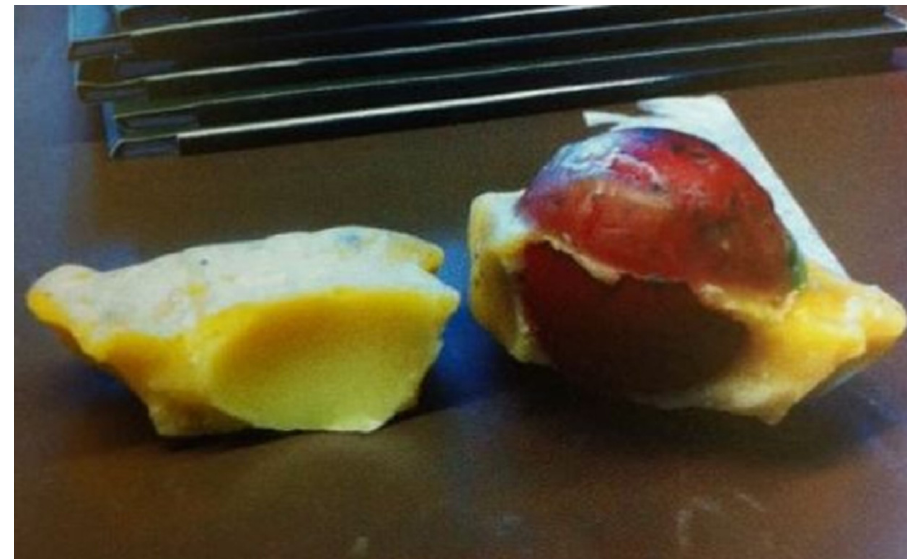
Figure 9. The PCM spheres after the tests in the experimental setup [30].